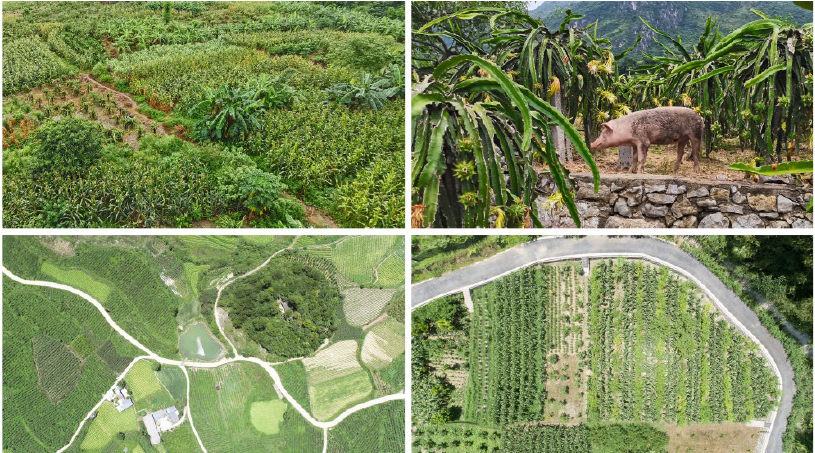
Figure 7. Vertical community structure and horizontal spatial structure of agroforestry complex systems.